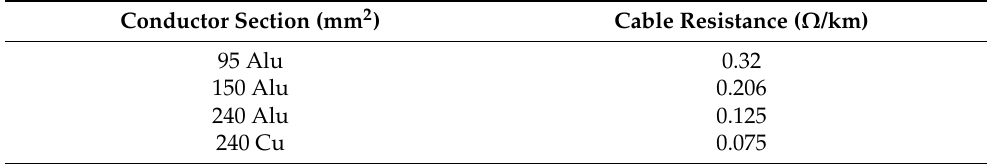
Table 4. Cables sections and resistance.